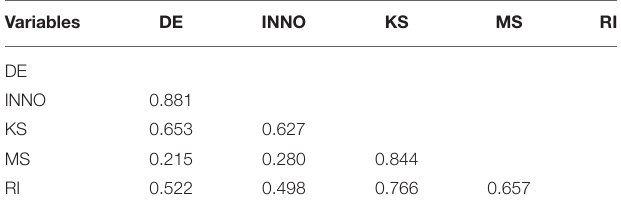
TABLE 2 | A measurement model and descriptive statistics.